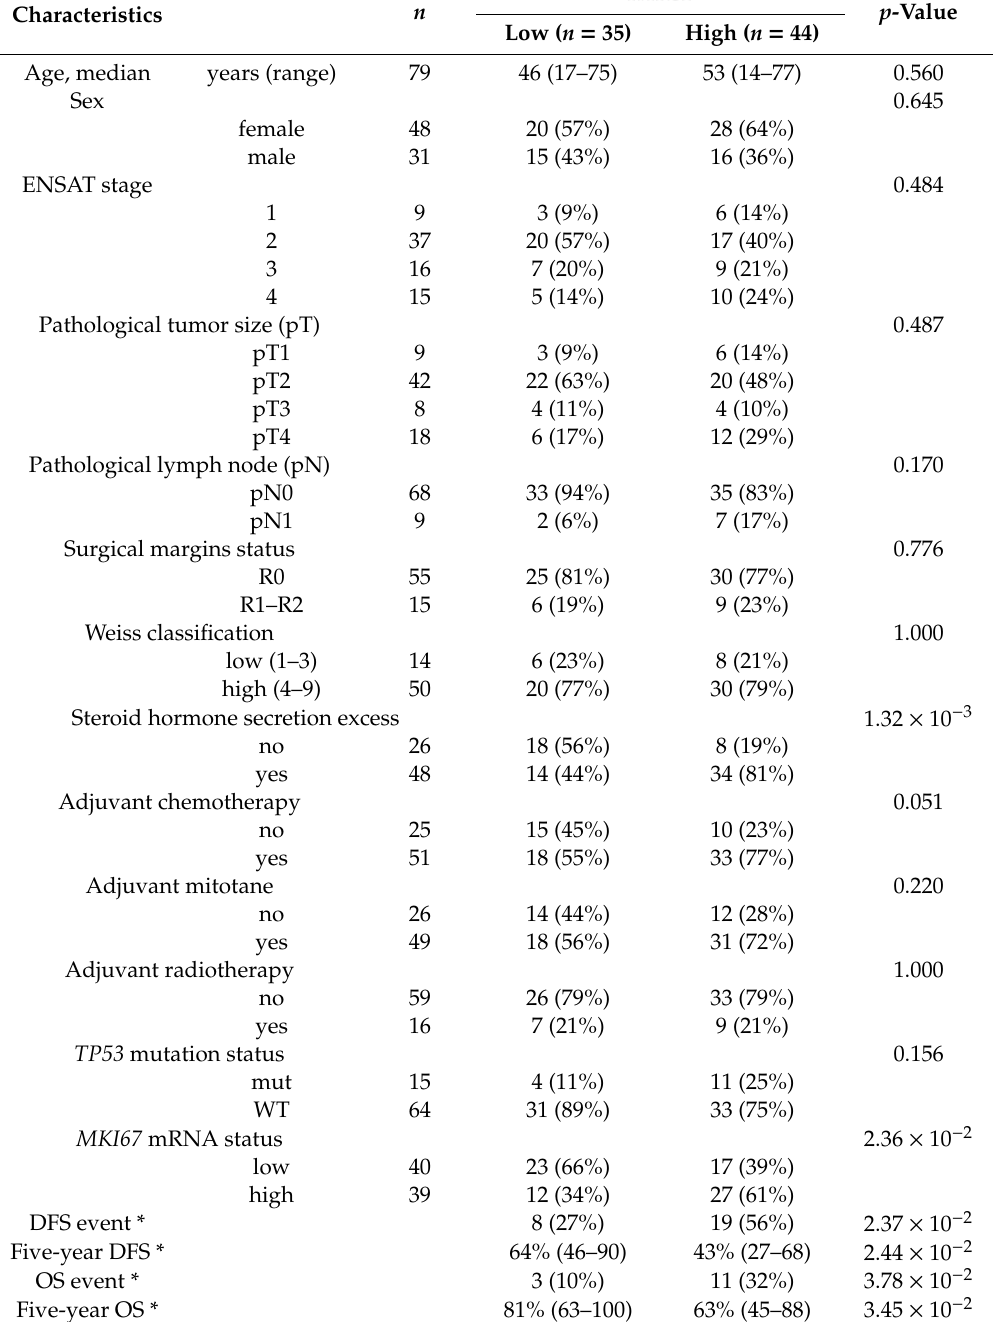
Table 2. Correlations of FATE1 mRNA expression with clinicopathological variables in adult ACC patients from